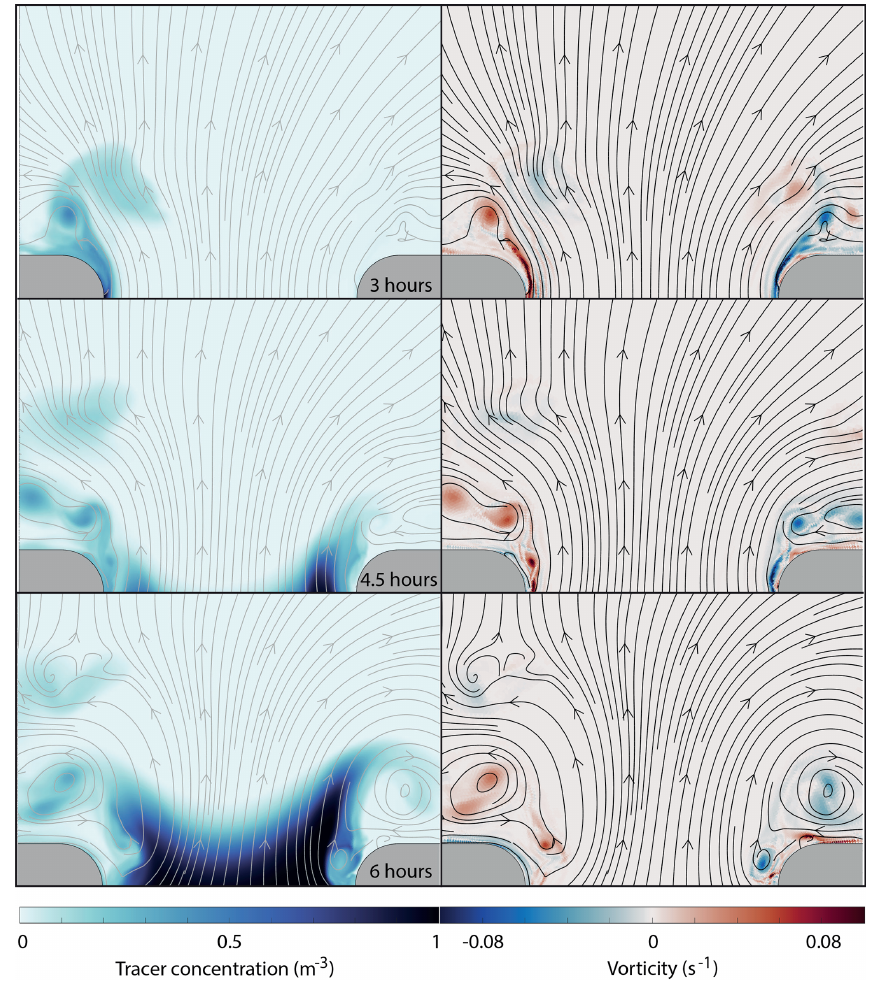
Figure 7. The temporal tracer and vorticity fields, with the corresponding stream function, are displayed for a 12km wide and 4km long strait in the left and right panel, respectively. The experiment is forced with a tidal wave of amplitude A t = 1m. The upper, middle, and lower panels show a snapshot in time of the tracer and the vorticity fields at 1.5, 3, and 4.5h after slack tide,